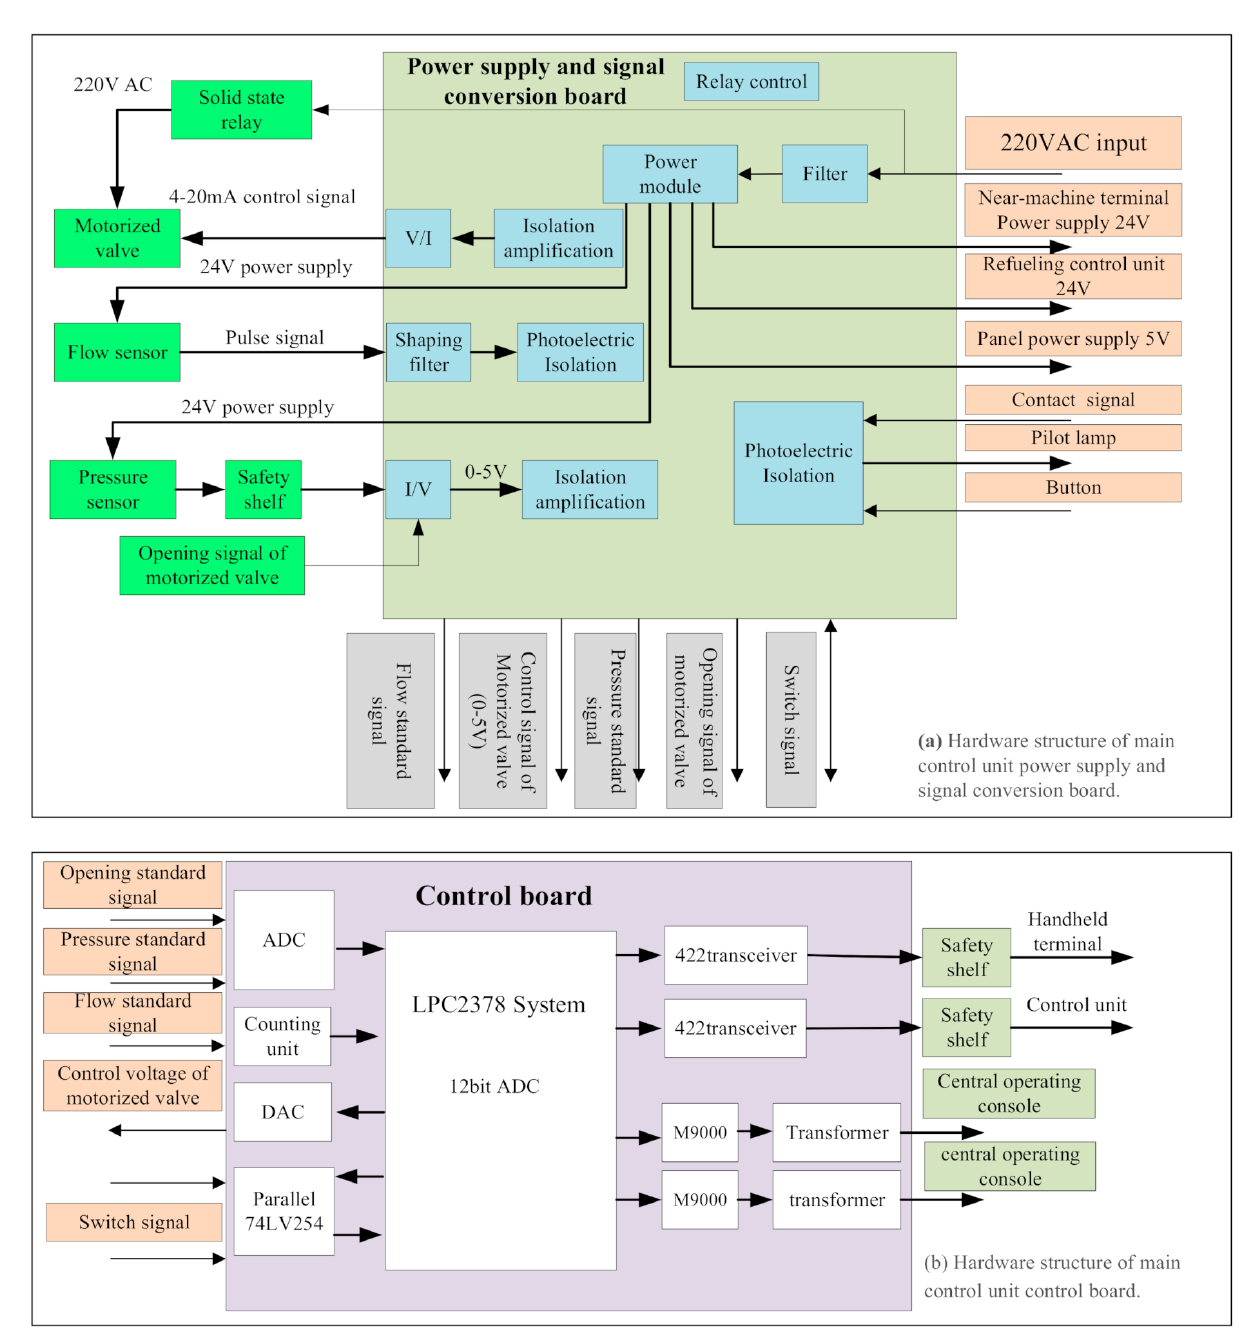
Figure 3. Internal circuit structure of